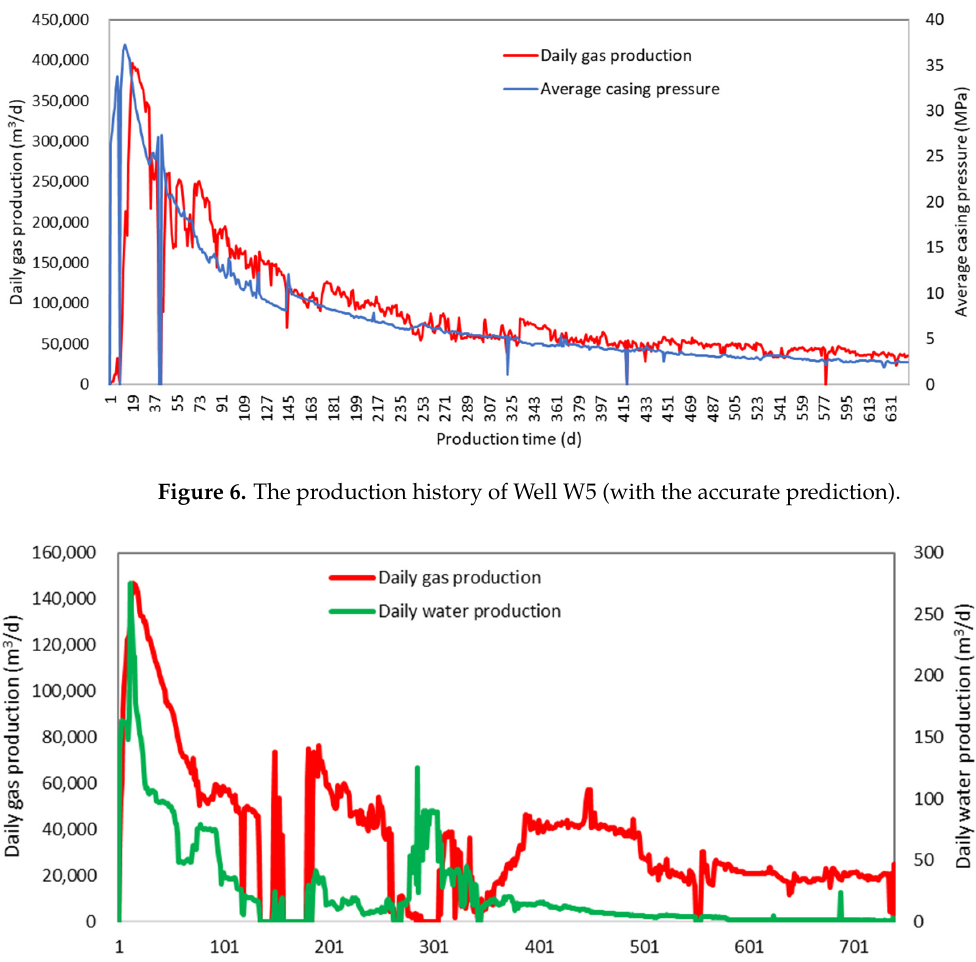
Figure 7. The production history of Well W1 (overestimated).